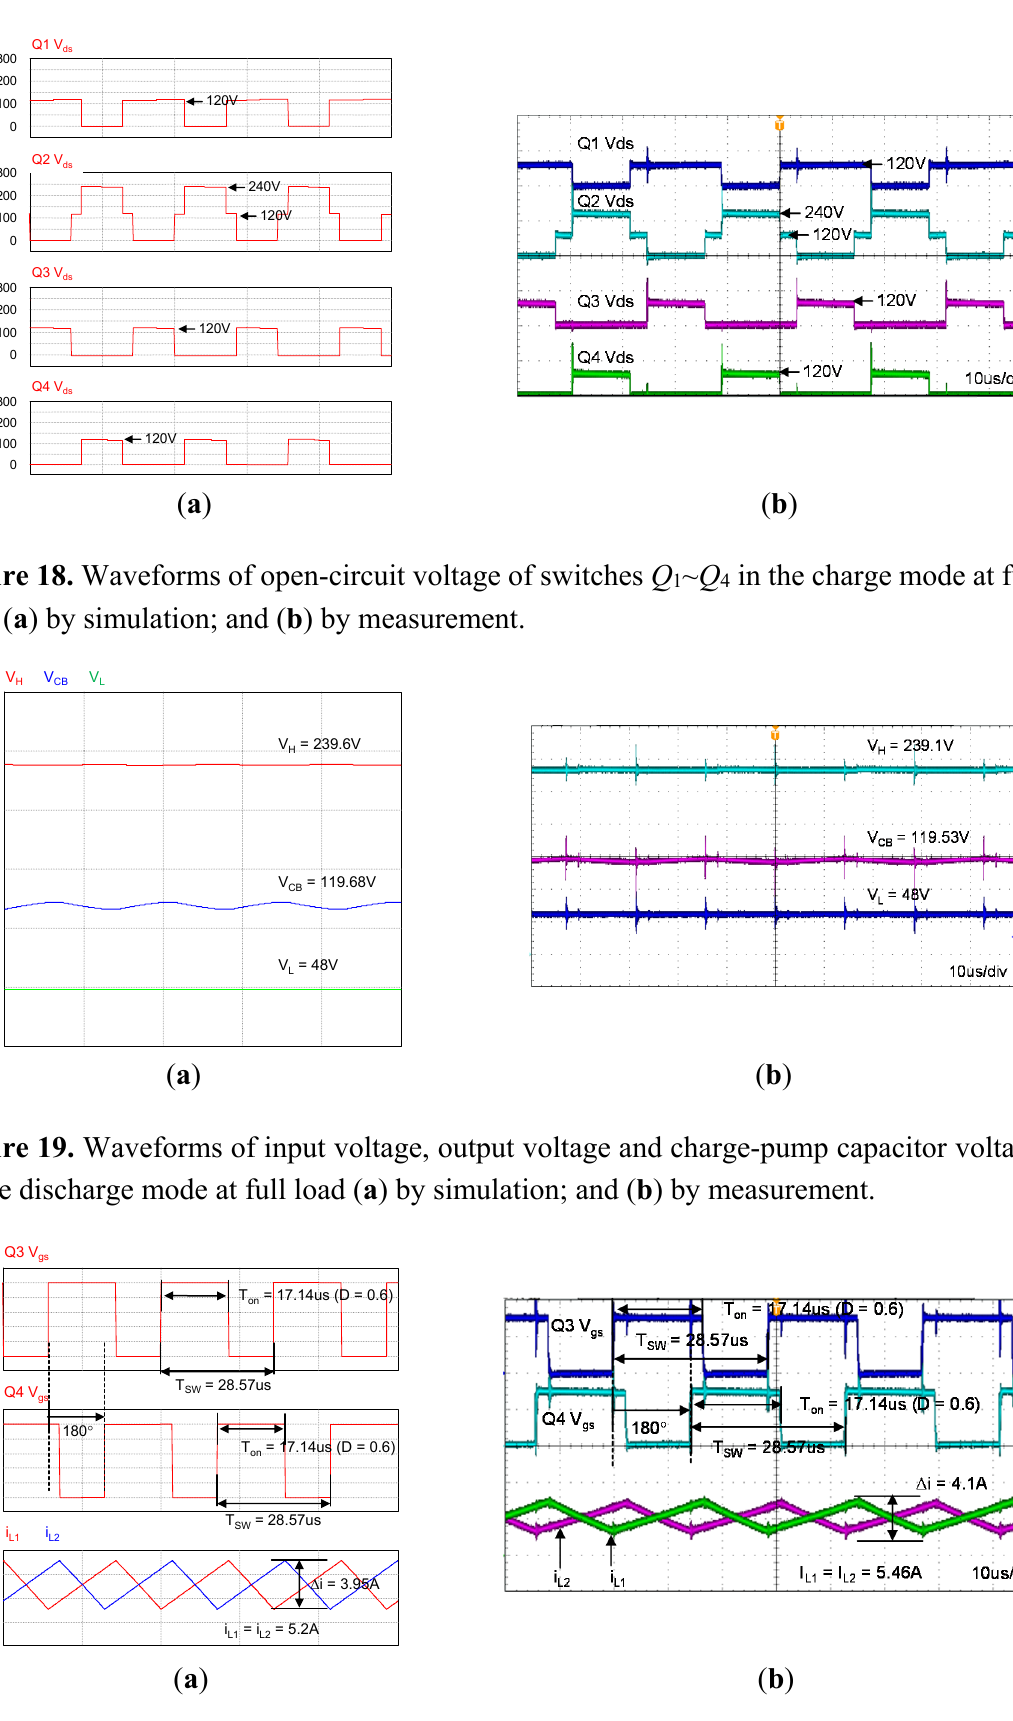
Figure 20. Waveforms of gate signals of low-side switches Q 3 ~ Q 4 , and two-phase inductor currents i L 1 ~ i L 2 in the discharge mode at full load ( a ) by simulation; and ( b ) by